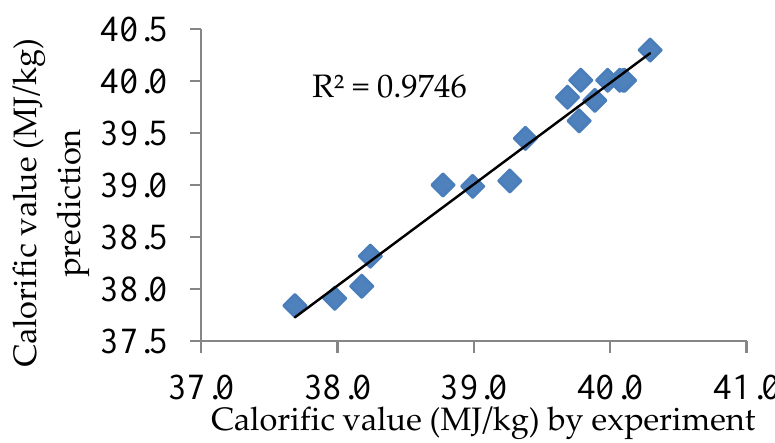
Figure 3. The plot of the experimental versus predicted rice bran methyl ester (RBME) blending with multi-walled carbon nanotubes (MWCNTs) calorific value using RSM.